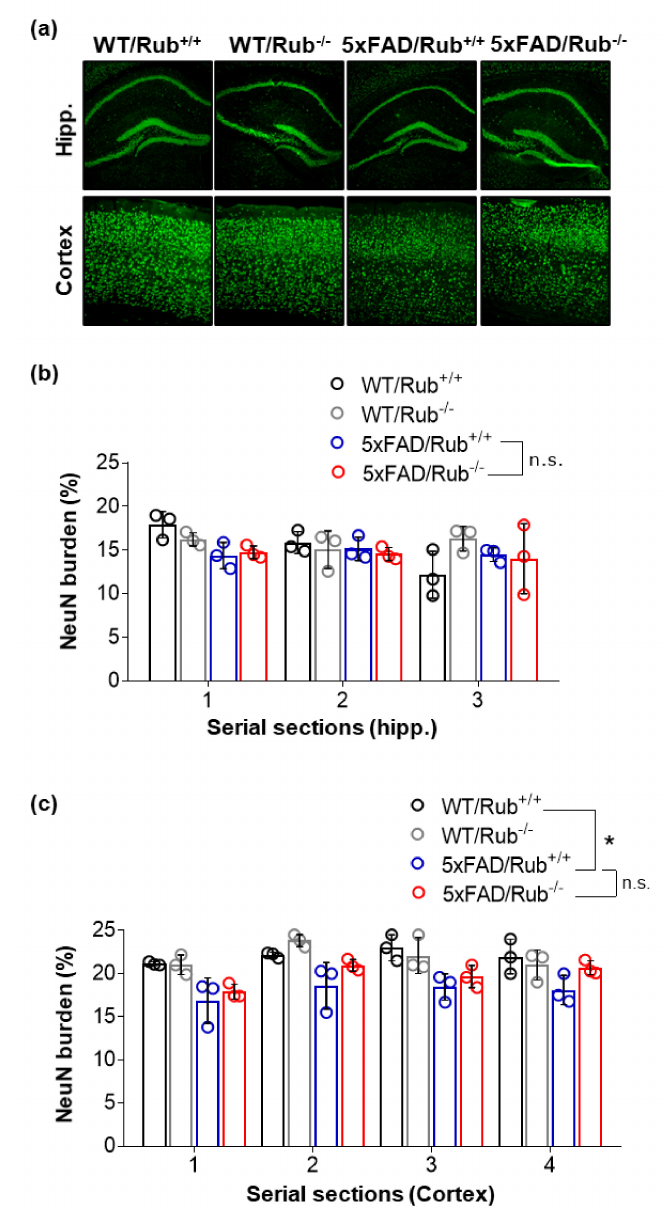
Figure 5. The lack of Rubicon in 5xFAD mice does not change the number of neurons in serial sections of the hippocampus and brain cortex tissues. ( a ) Representative Z-stack of confocal im- ages of immunocytochemistry for the detection of neurons (NeuN, green) in the hippocampus (upper layer) and cortex (lower layer) of wild-type mice with and without regular expression of Rubicon (WT/Rub+/+; WT/Rub − / − ) and 5xFAD mice with and without expression of Rubicon (5xFAD/Rub+/+; 5xFAD/Rub − / − ). ( b , c ) Quantification of the intensity of fluorescence of neuronal marker NeuN in serial sections of the hippocampus ( b ) and cortex ( c ) of four genotypes analyzed. Data are mean ± SEM. * p < 0.05 as determined by repeated-measures ANOVA, n.s., no